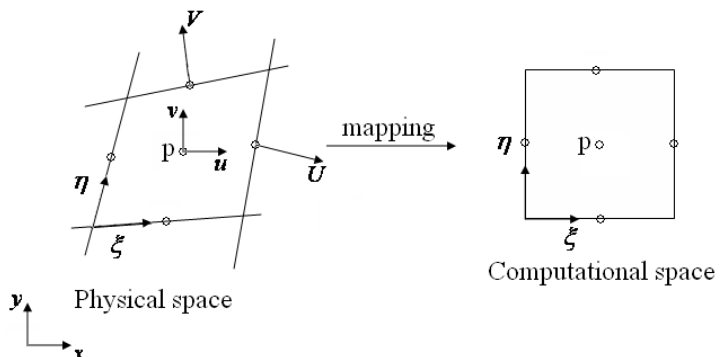
Fig. 1. A control volume of the non-staggered grid and mapping in the two